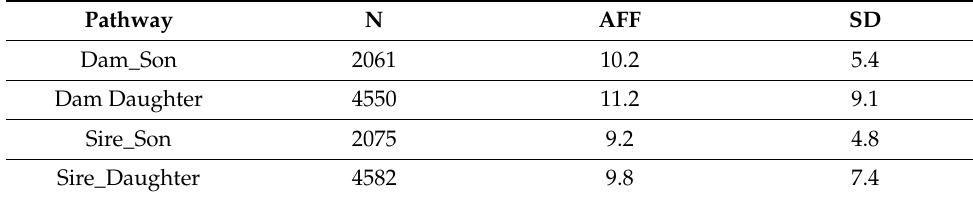
Table 6. Age at first foaling (AFF) and standard deviations (SD) expressed in years.